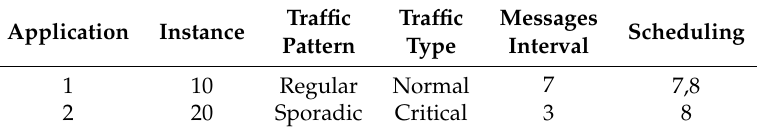
Table 5. Scheduling of DYNASTI with two